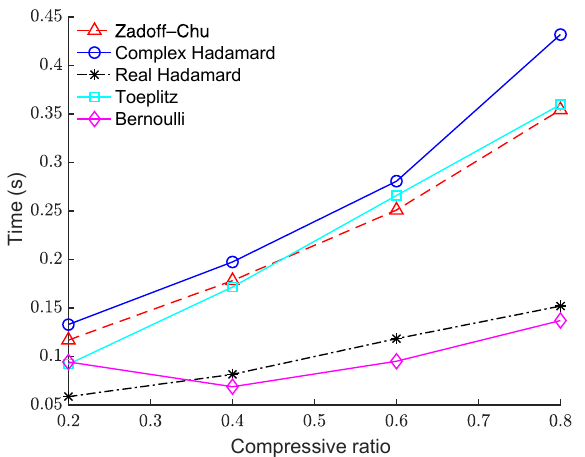
Figure 7. Comparison of the run times of different measurement matrices on the “House” image.